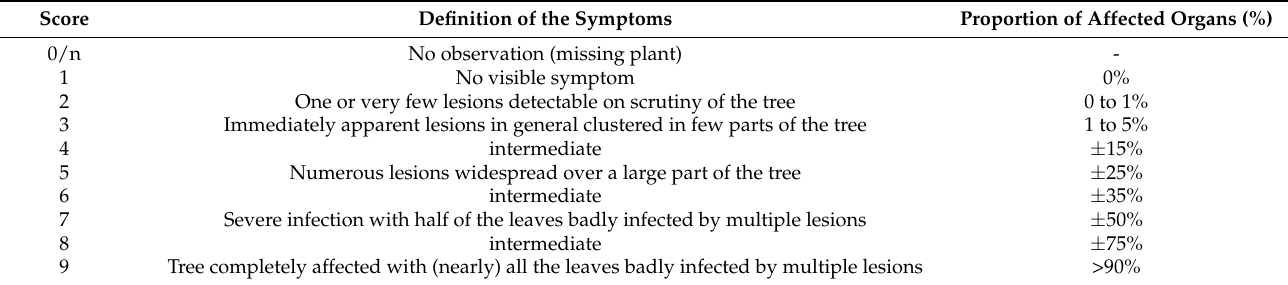
Table 2. Apple scab severity scoring